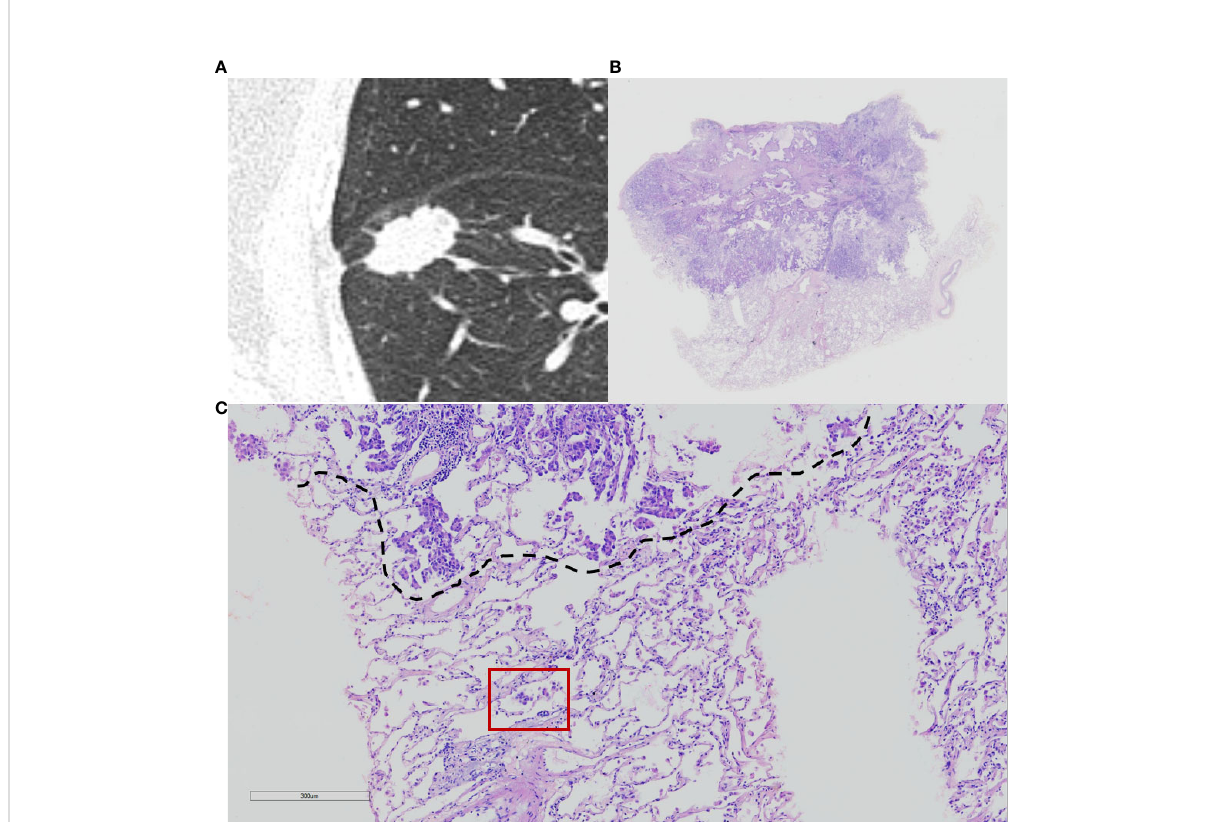
FIGURE 1 Computed tomography (CT) and histology images of spread through air space (STAS)-positive lepidic lung adenocarcinoma. (A) CT image (width, 1,500 HU; level, − 600 HU) shows a solid nodule with lobulation, spiculation, and pleural indentation signs; (B) photomicrograph shows a distinct border between the solid tumor and lung parenchyma (hematoxylin and eosin [HE] stain, ×10); (C) micropapillary pattern of STAS (red square) identi fi ed within air spaces in the lung parenchyma beyond the edge (dashed line) of the main tumor (HE stain,